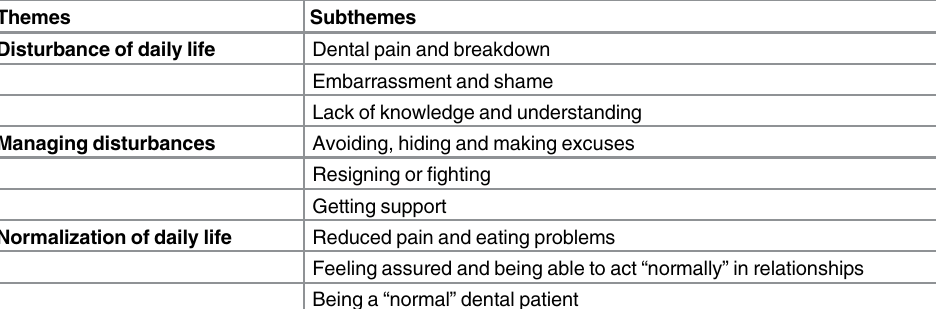
Table 2. Themes and subthemes explaining the experiences of patients living with enamel distur- bances caused by AI and receiving early crown therapy.